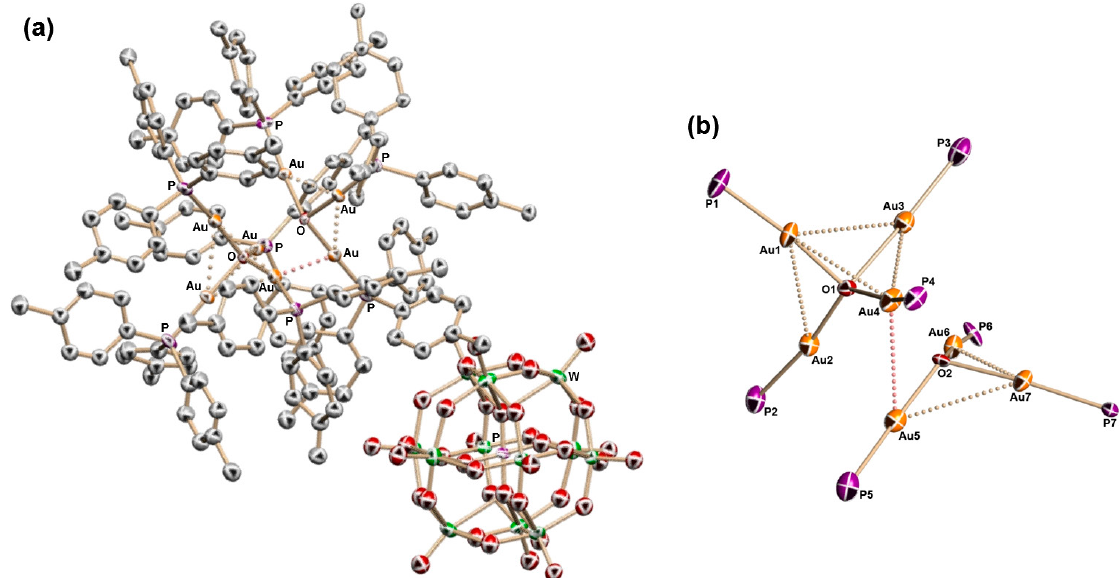
Figure 2. ( a ) Molecular structure of 5 ; ( b ) The partial structure of the heptagold(I) cluster cation.